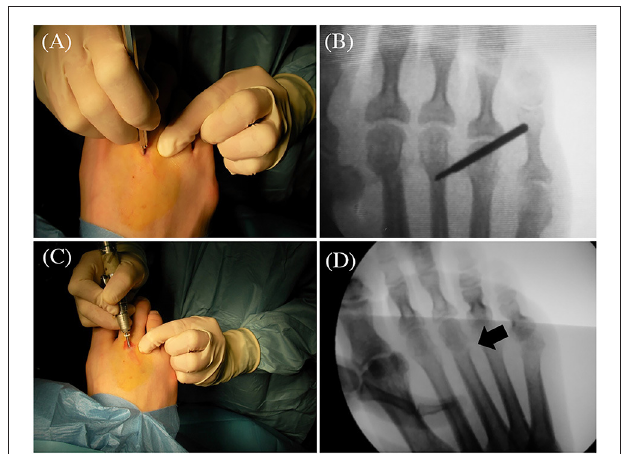
FIGURE 1 | Details of the surgical technique. (A) Surgical incision of the 3rd metatarsal; (B) Position of the burr; (C) Performance of the osteotomy; (D) Fluoroscopic control of the metatarsal